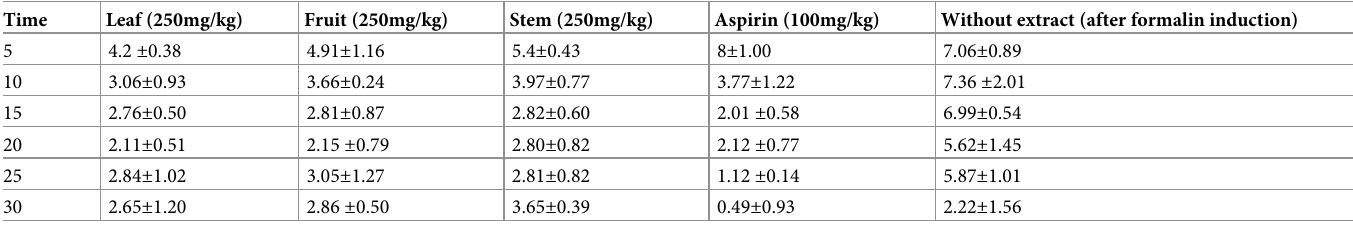
Table 6. The formalin—induced hind paw licking in mice technique was used to test the analgesic efficacy of a methanolic extract of E . spinosa leaf, fruit, and stem at a concentration of 250 mg/kg. Time Leaf (250mg/kg) Fruit (250mg/kg) Aspirin (100mg/kg) Without extract (after formalin